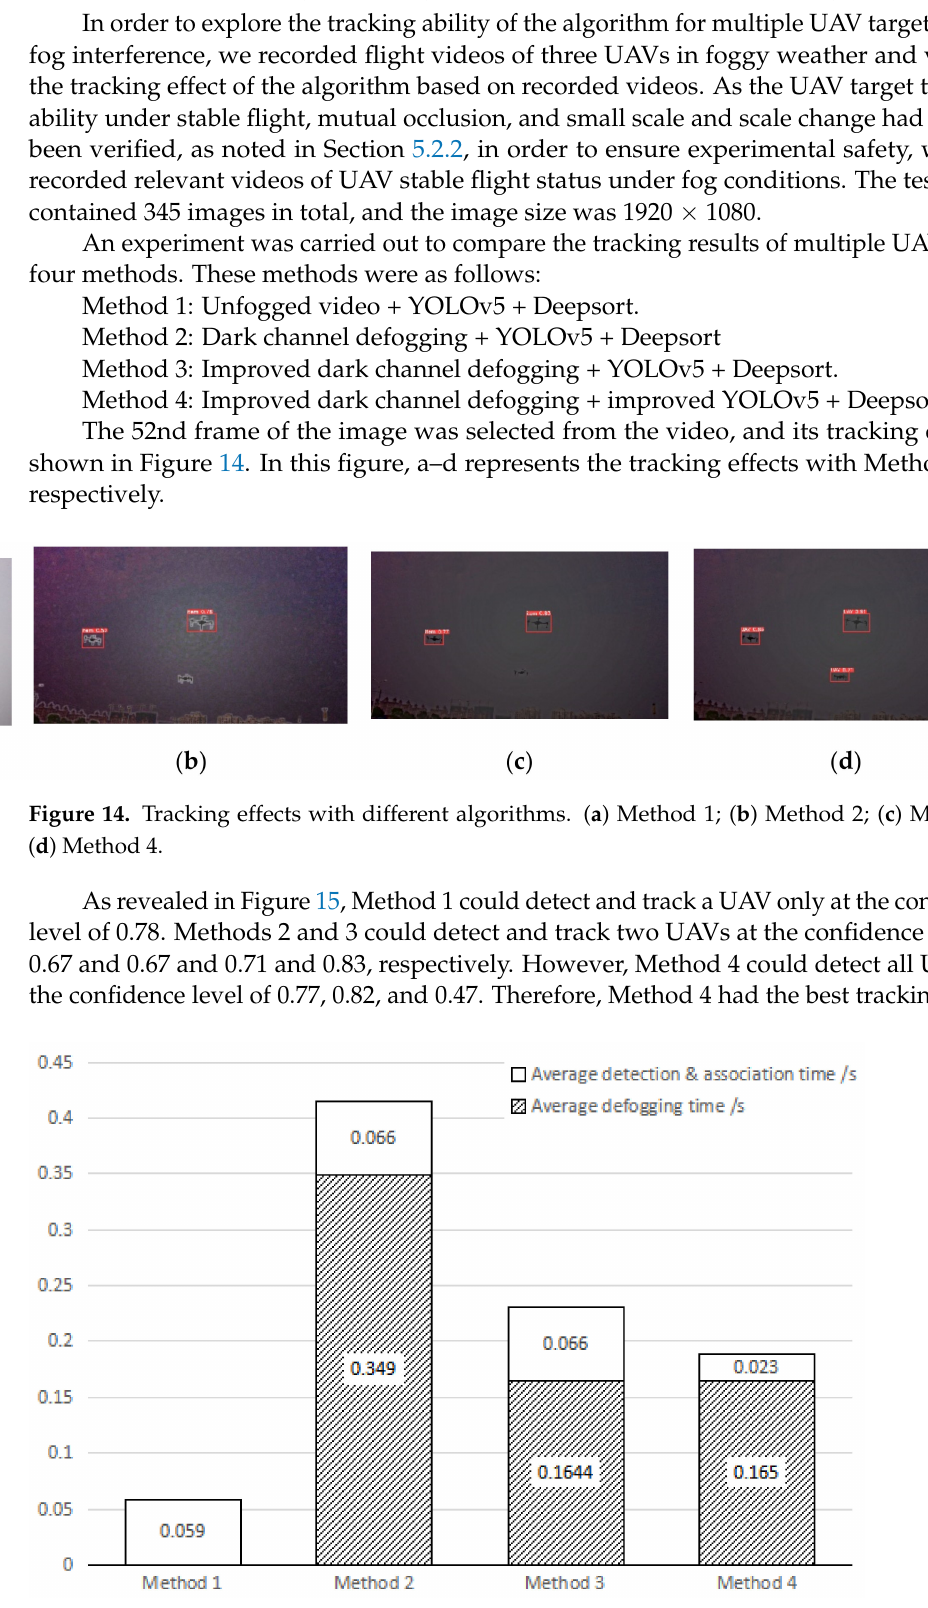
Figure 15. Average object tracking time per frame of the image with different